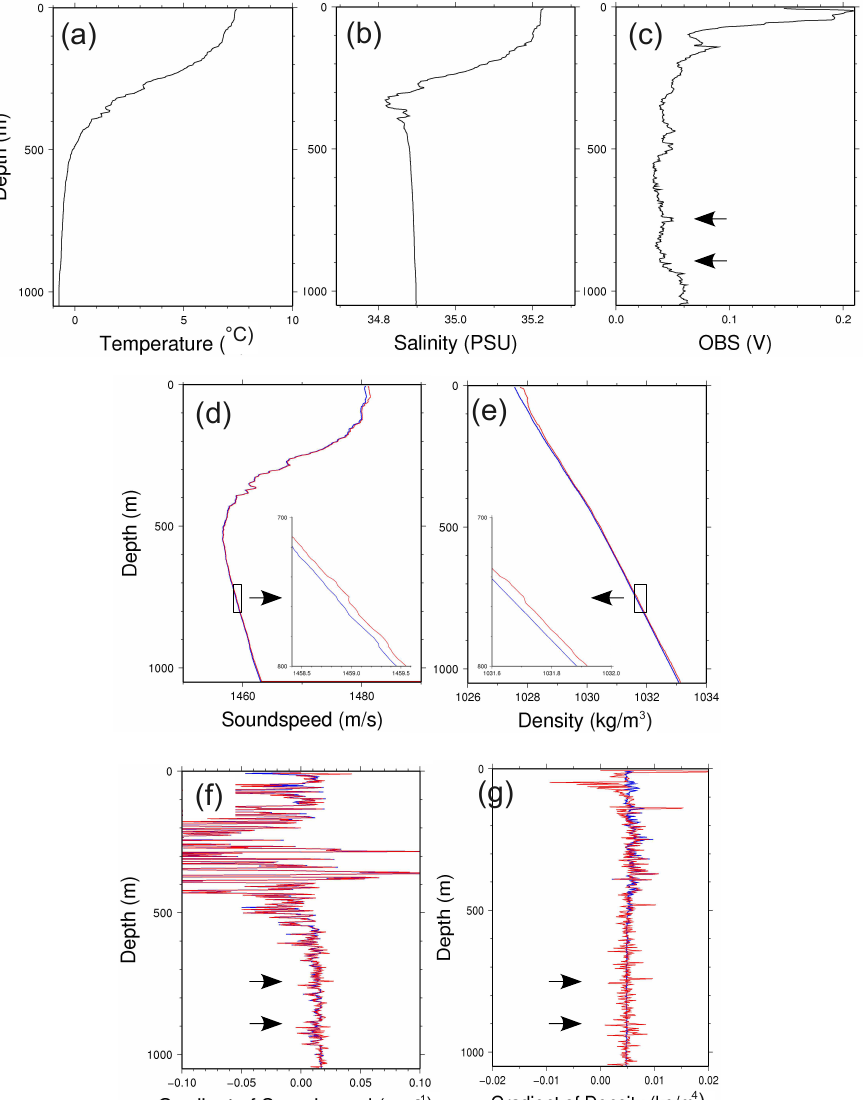
Fig. 2. (a) temperature, (b) salinity and (c) optical back-scatter from the CTD cast (crossed red dot Fig. 1c). (d) corresponding sound-speed and (e) the density profiles without (blue) and with (red) the addition of suspended sediment (assumed to be quartz). The intrusion at 750m shown in insert. (f) and (g) the vertical gradient of sound-speed and density respectively again without and with suspended sediment. The effects of intrusion at 750m and near seabed sediment load are highlighted by arrows. the seismic image (Fig. 1b) are wholly within the